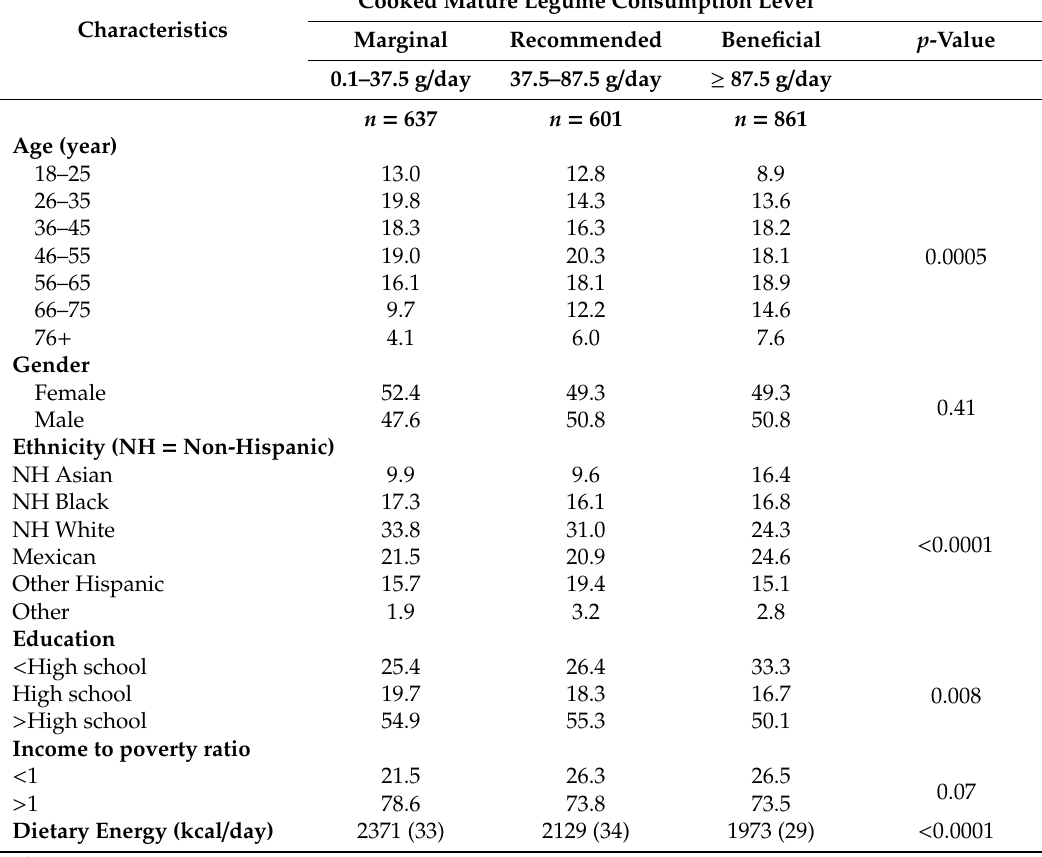
Table 5. Demographic characteristics among mature-legume consumers, stratified by dietary recommendations for cooked mature legume consumption (37.5 g / day) and amounts demonstrating nutritional and disease prevention benefits (87.5 g / day): National Health and Nutrition Examination Survey (NHANES) 1